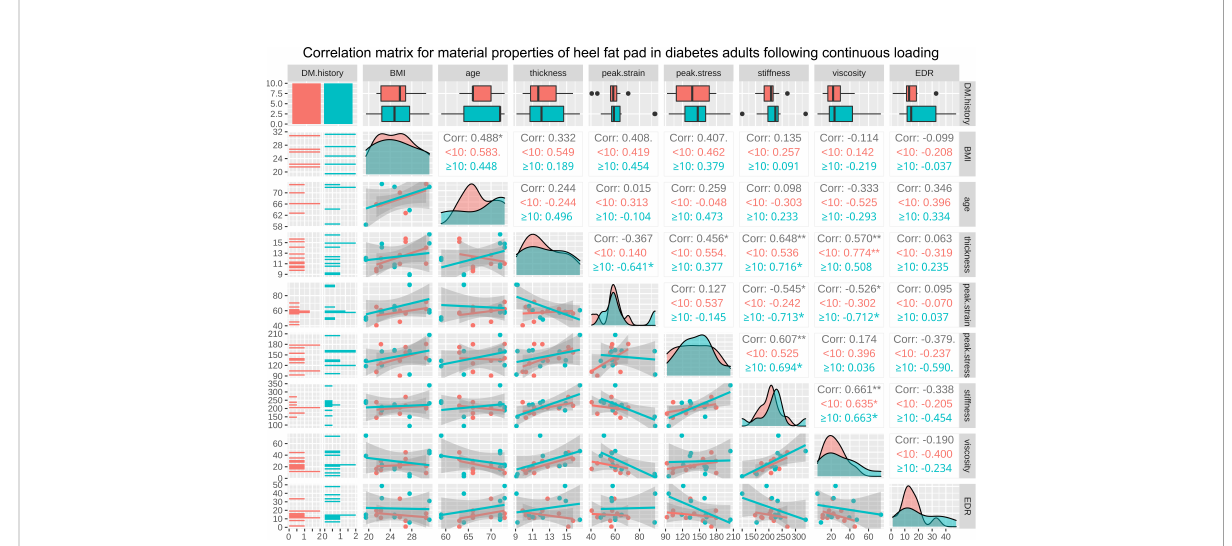
FIGURE 7 The correlation matrix for BMI, age, primary thickness, peak strain, peak stress, stiffness, viscous modulus, and EDR of heel in diabetes subjects following continuous loading. The values displayed in the right-upper triangle represent the Pearson ’ s correlation coef fi cients (R values). The lower-left triangle displays the scatter plots and regression lines. The plots on the diagonal line present the distribution density of the variables in the matrix. Subgroup analysis was conducted basing on the diabetes course (<10 years and ≥ 10 years), and red colour represents subgroup of <10 years while cyan colour represents subgroup of ≥ 10 years. BMI: body mass index; EDR= energy dissipation rate. P values:.p<0.100, *p<0.050,